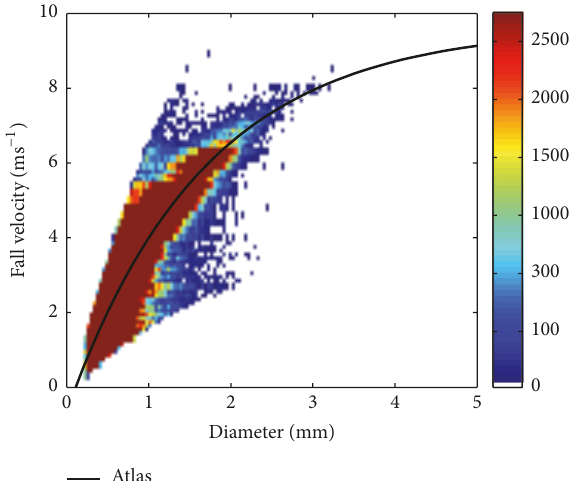
Figure 18: Fall velocity of raindrops (the black solid line represents the Atlas model for the rainfall velocity).